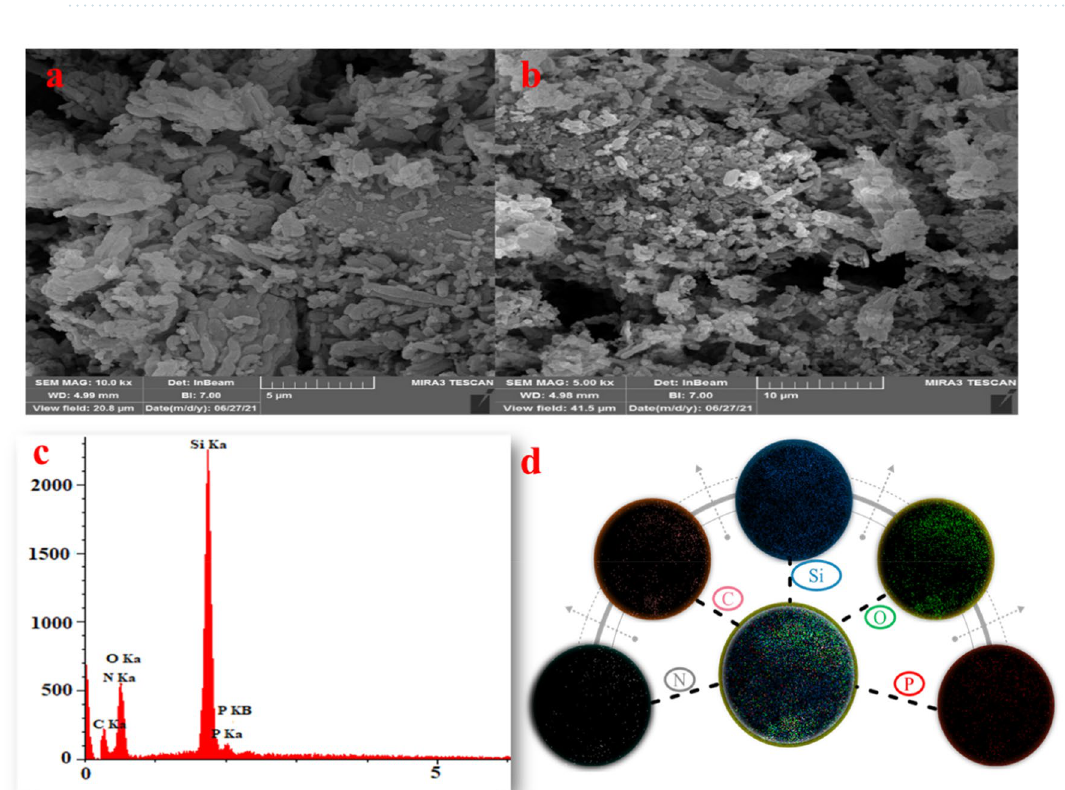
Figure 8. ( a , b ) Scanning electron microscope (SEM) images of CQDs-N(CH 2 PO 3 H 2 ) 2 /SBA-15. ( c ) Energy dispersive X-ray analysis (EDX) and ( d ) SEM-elemental technique of CQDs-N(CH 2 PO 3 H 2 ) 2